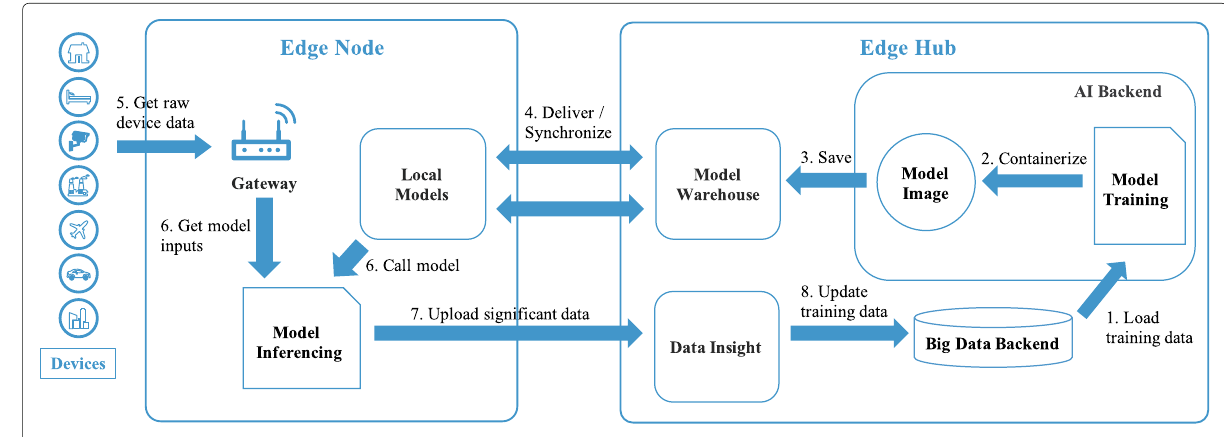
Fig. 6 The process of model evolution and